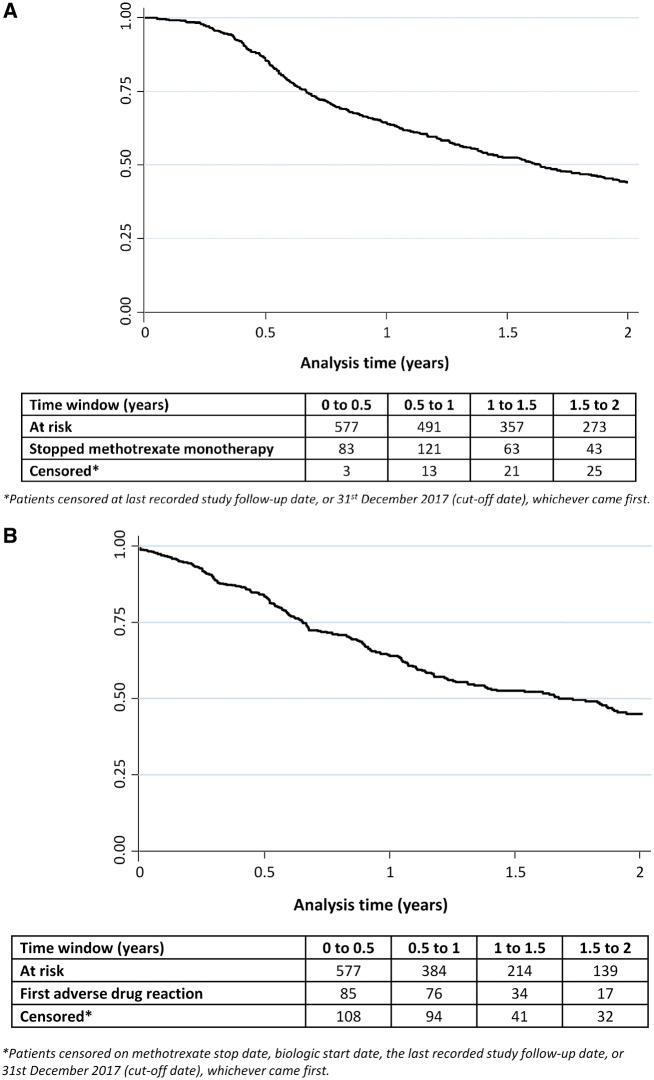
Kaplan–Meier survival graphs of patients with JIA on MTX monotherapy(A) Survival analysis in patients with JIA over the first 2 years of MTX monotherapy (N = 577). (B) Time to first ADR over the first 2 years of MTX monotherapy (N = 577).